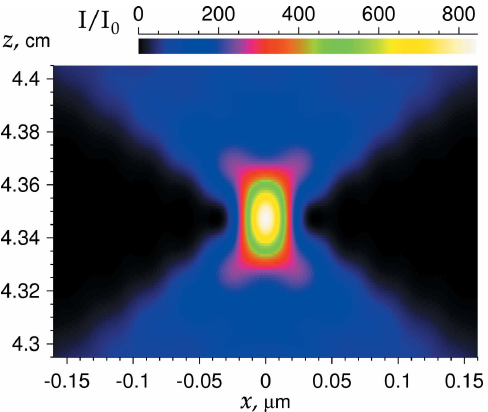
Figure 2 Relative intensity distribution near the focal distance. See details in the text.